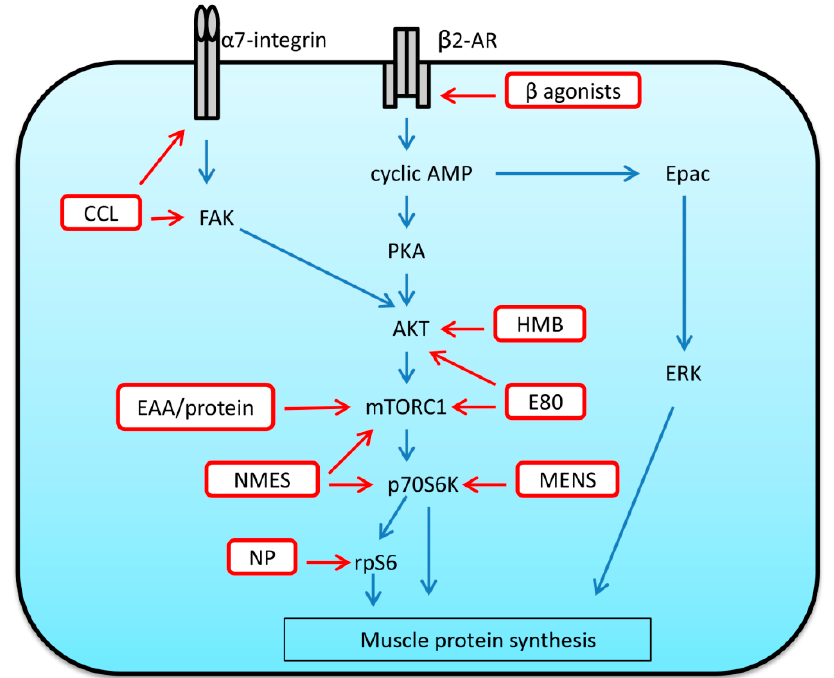
Figure 4. Schematic illustration of the effects of possible therapeutic interventions on the anabolic pathways in reloaded skeletal muscle. Arrows indicate stimulatory signals. β 2-AR—beta 2